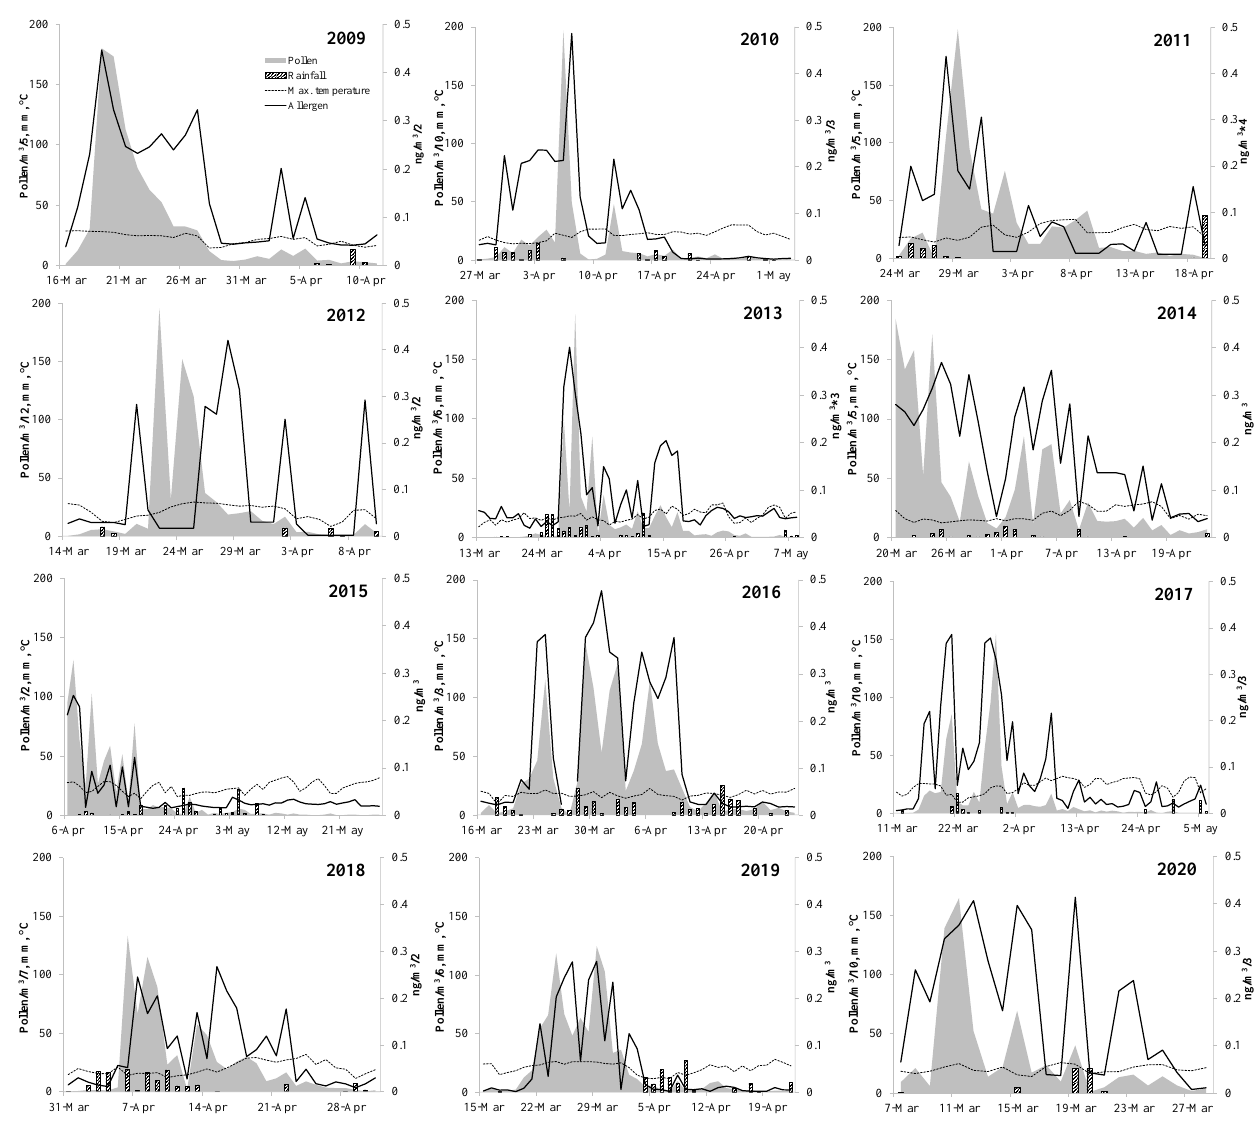
Figure 3. Pollen grain concentrations (grey area), allergen concentrations (black line), maximum temperature (dash line), and rainfall (bars) for Platanus during the main pollen season on each study year.